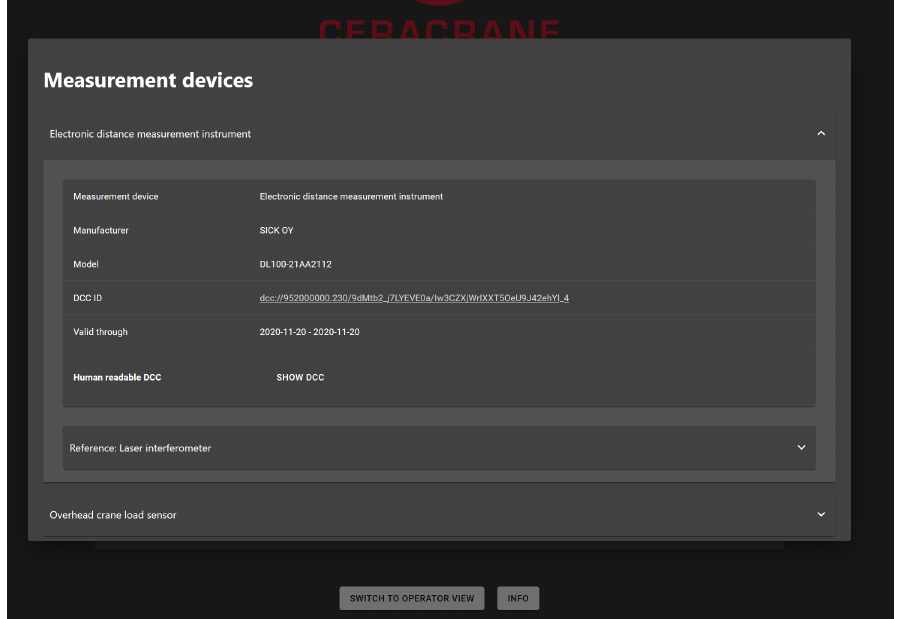
Figure 5. The UI showing the information of the measurement devices in the device details view.